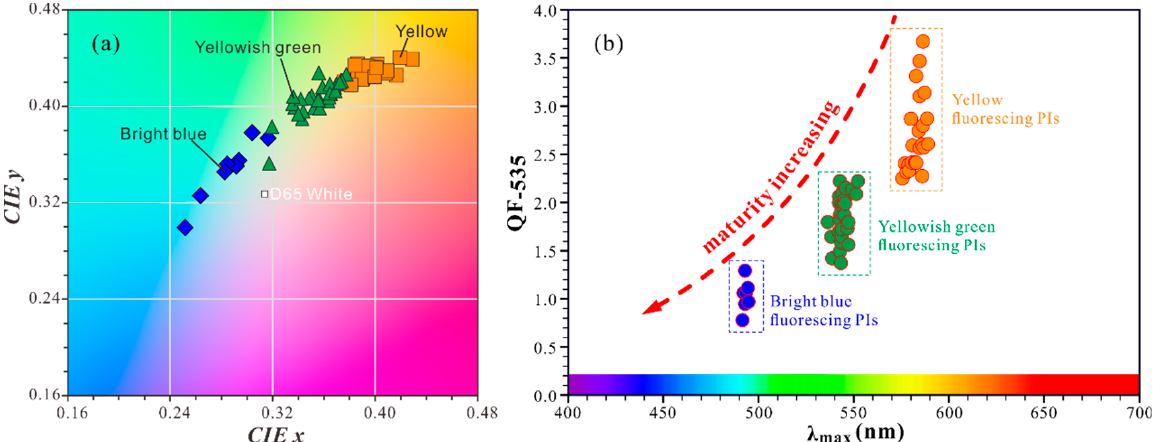
Figure 6. Chromaticity diagram ( a ) and spectrum parameters plots of QF-535 versus λ max ( b ) of petroleum inclusions.